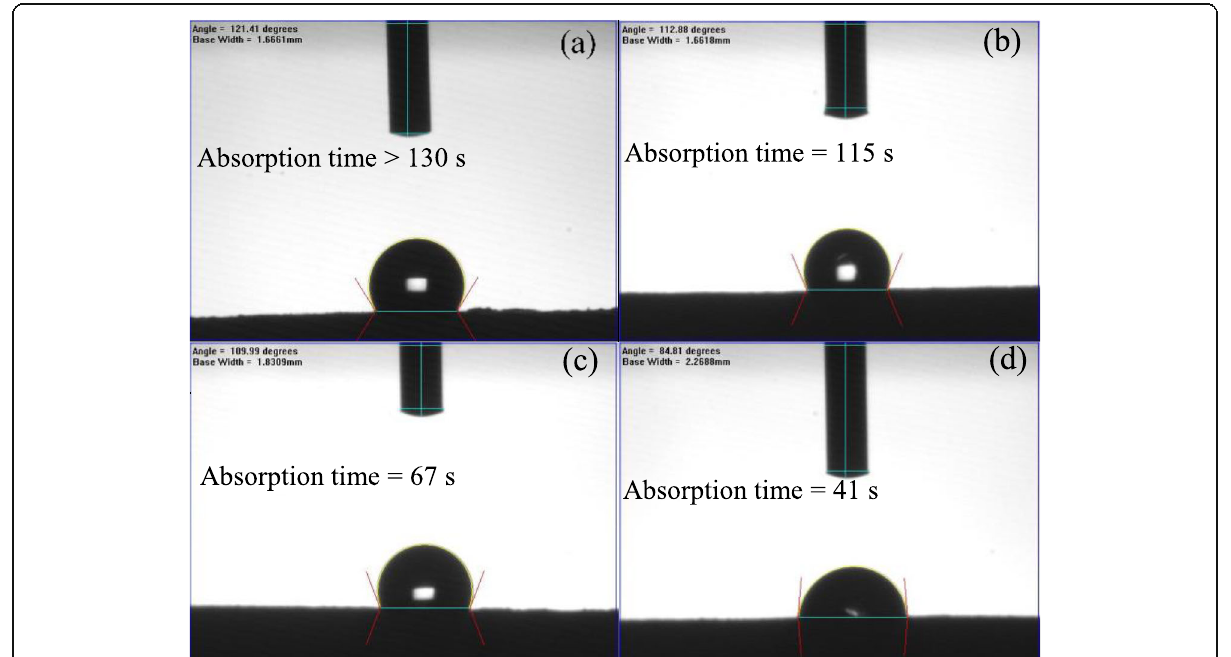
Fig. 7 Surface contact angle of ( A ) IHC-0, ( B ) IHC-38, ( C ) IHC-48 and ( D )